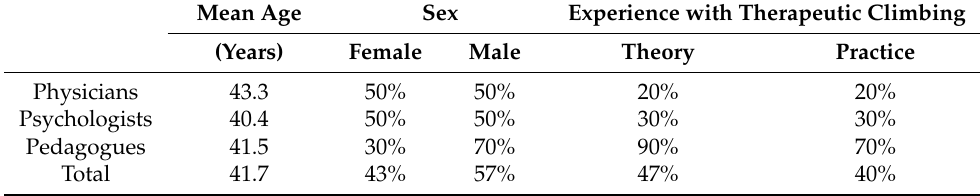
Table 1. Participant